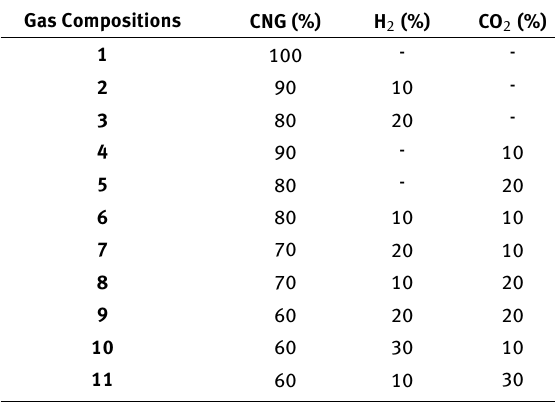
Table 1: Gas Compositions.